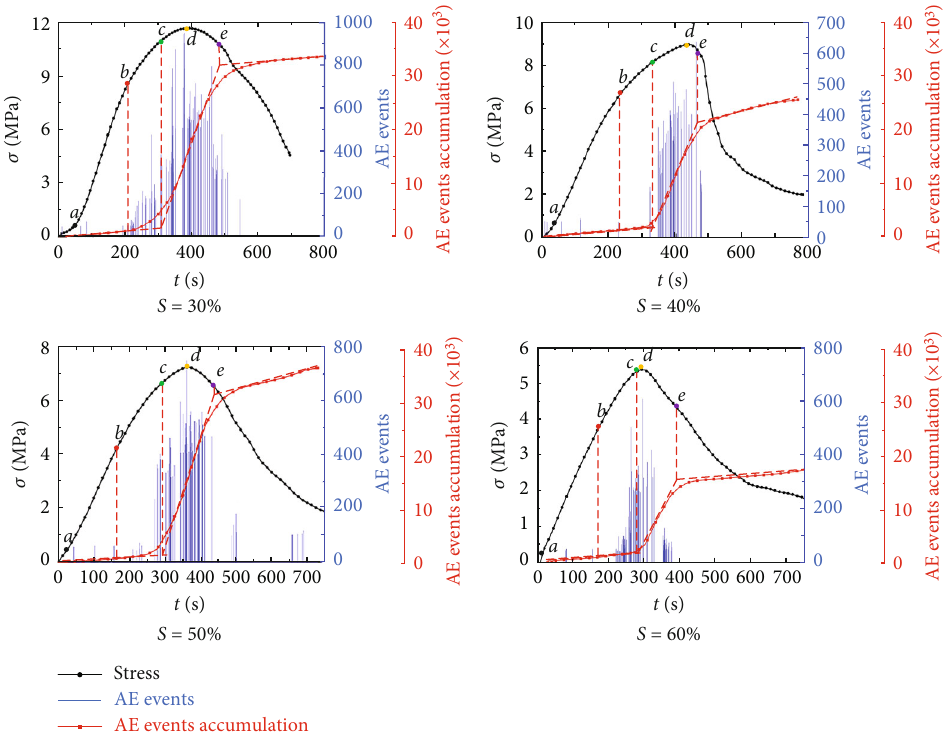
Figure 11: Comparative analysis of stress and acoustic emission signals under the di ff erent proportion of clay